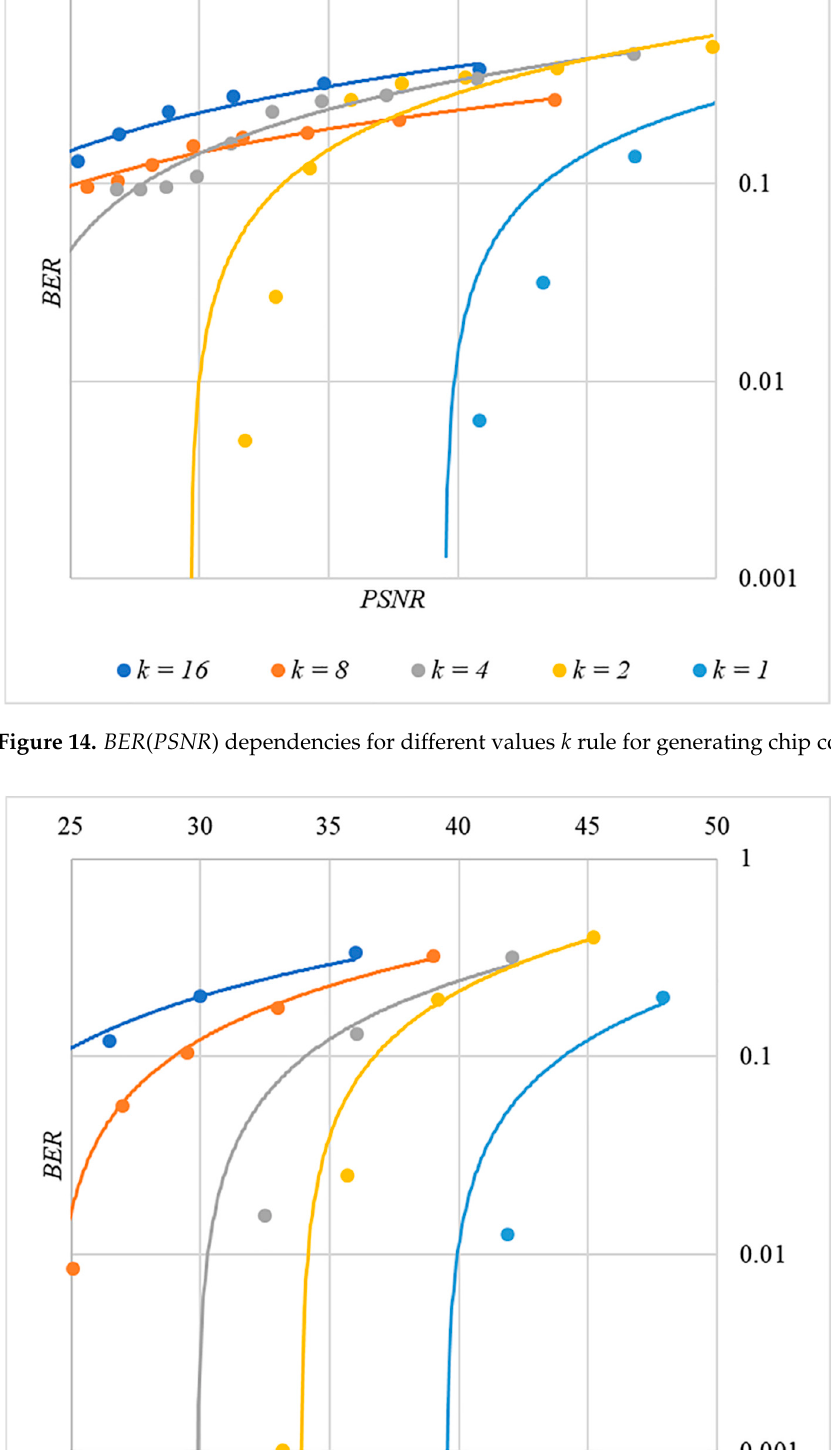
Figure 13. BER ( PSNR ) dependencies for different values k rule for generating chip codes № 1.